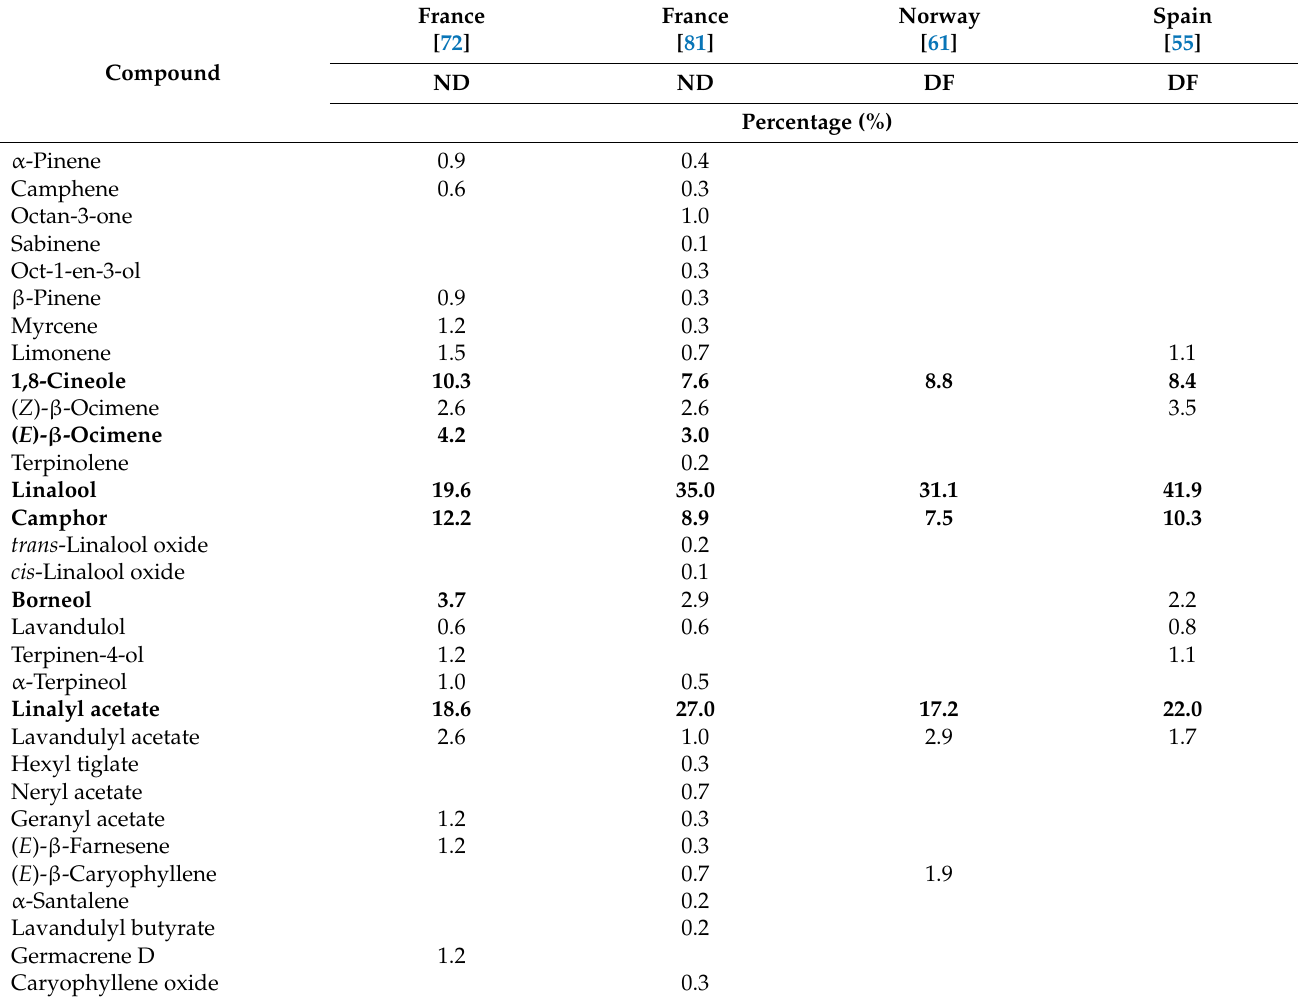
Table 7. Exemplary L. × intermedia ‘Abrial’ essential oil compositions from different